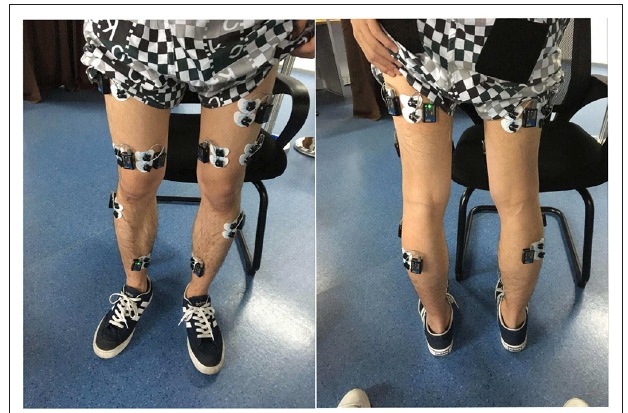
FIGURE 1 | EMG electrode locations on the lower limb of one able-bodied subject.